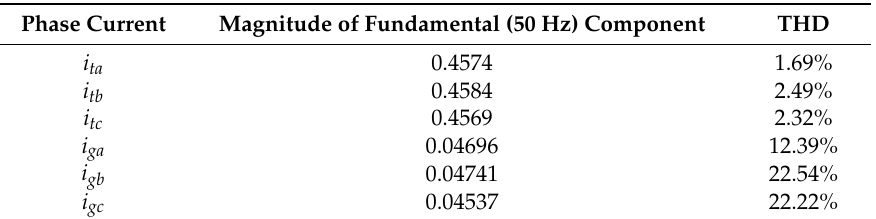
Table 6. Total harmonic distortion (THD) of three-phase currents.